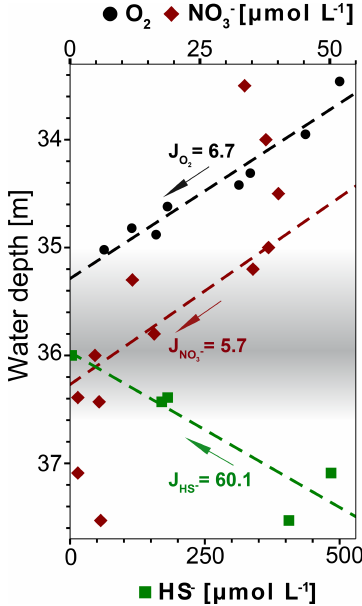
Figure 8. Concentration profiles of dissolved O 2 , NO − (calculated with PHREEQC) in water depths around the redoxcline. The fluxes J are given in 10 − 5 µmolm − 2 s − 1 . The linear fit of O 2 and HS − is calculated for the range of plotted values, while for NO − it is calculated only for the range from 34.4 to 36.6m water 3 depth. Only O 2 values above detection limit (6.3µmolL − 1 ) from winch profile 2 were considered for the calculation (Table